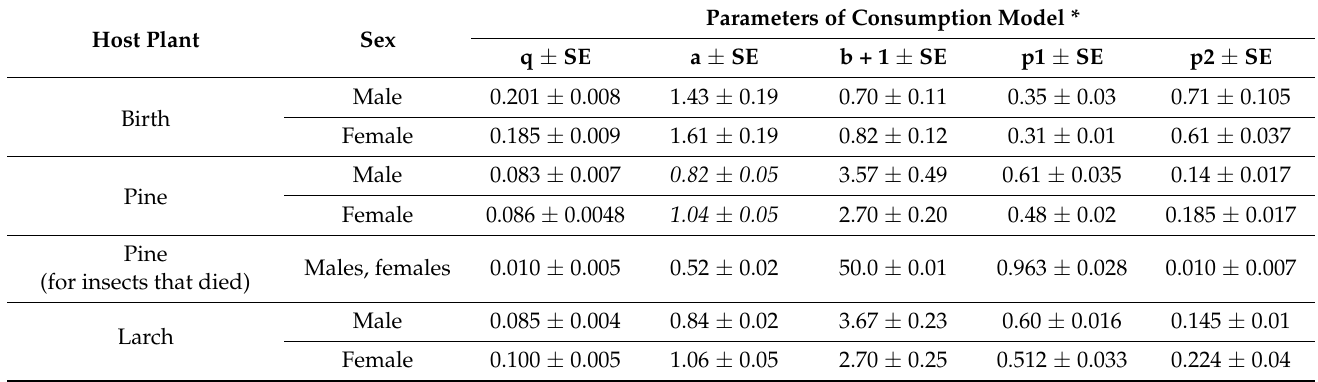
Table 1. Consumption model parameters for pupating females and males that fed on different types of feed. Errors refer to standard